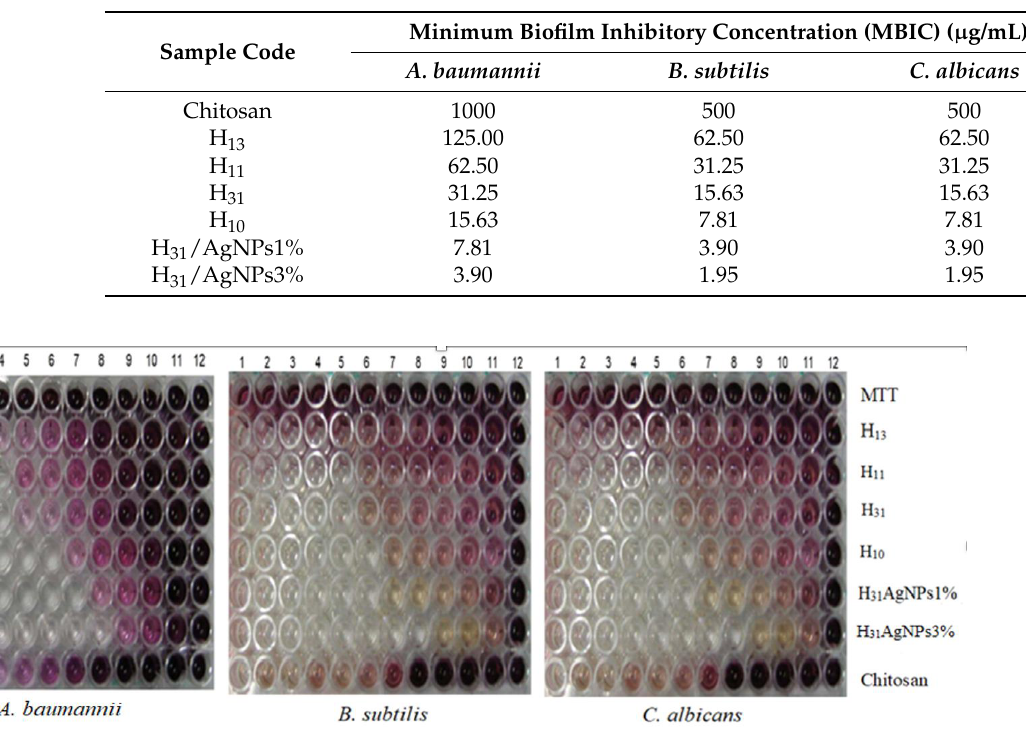
Figure 12. Normal images of anti-biofilm conduct of the prepared hydrogels against A. baumannii, B. subtilis , and C. albicans. B. subtilis , and C. albicans